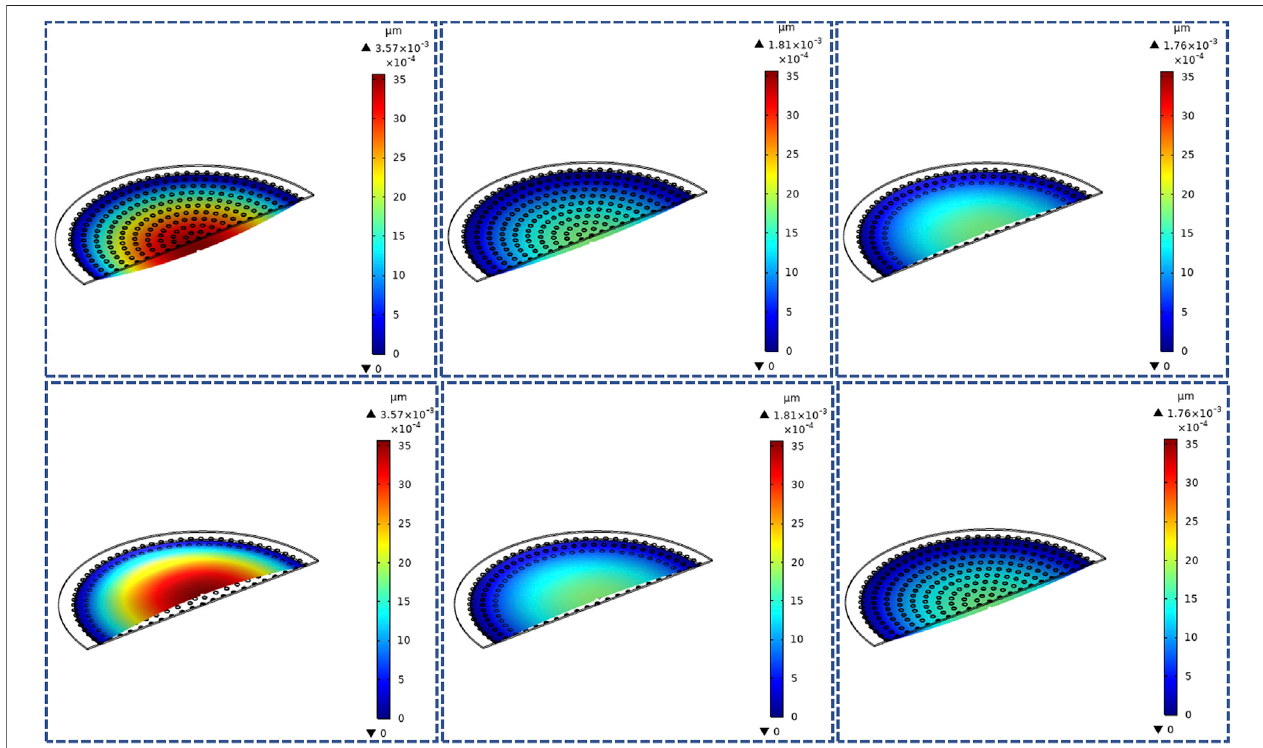
FIGURE 5 | Displacement of the membrane at different times of 1